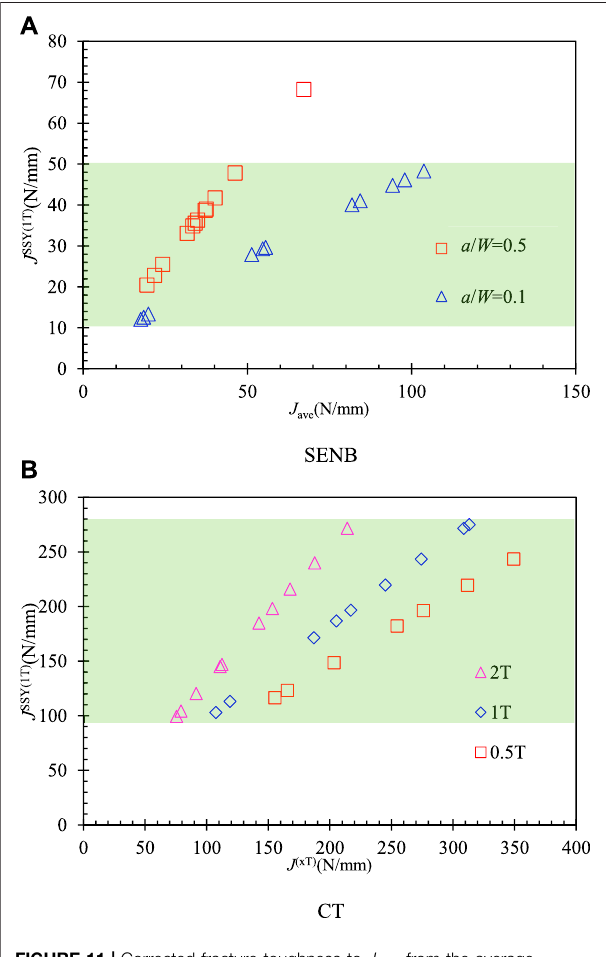
Frontiers in Materials |